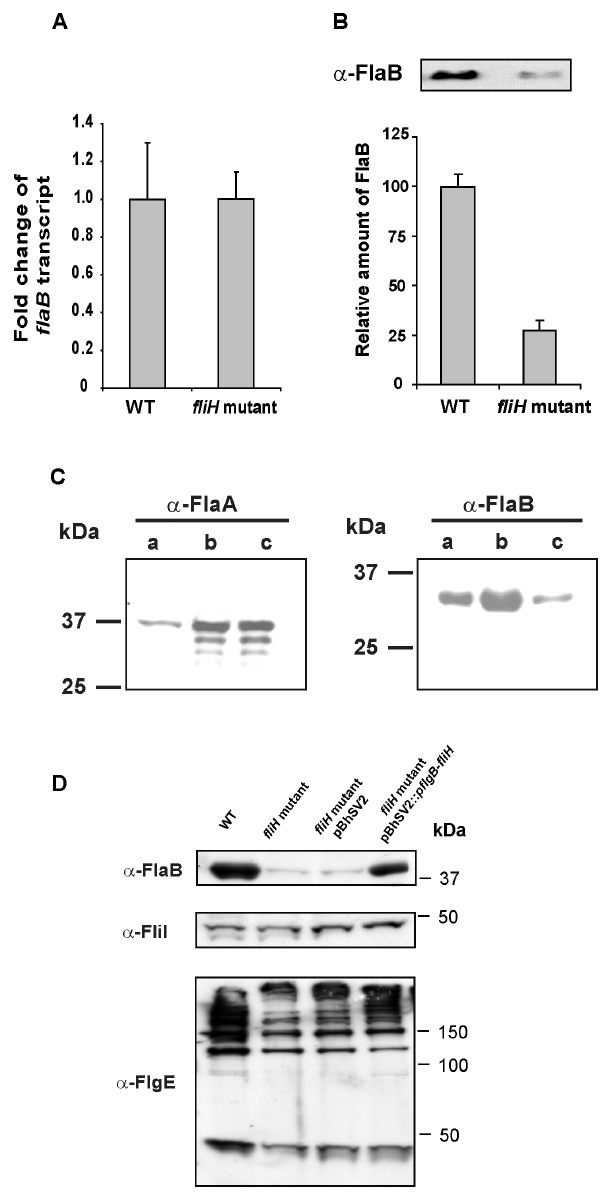
Figure 6. Comparison of flaB gene transcription and synthesis of flagellar proteins in B. hermsii wild-type (WT) and fliH mutant. (A) Fold change of flaB transcript normalized to glpQ transcript was obtained from 3 individual cultures of WT and fliH mutant spirochetes. (B) Relative amounts of FlaB protein were normalized to GlpQ protein measured by semi-quantitative immuno- blot using 3 lysates of the WT and mutant B. hermsii . (C) Immunoblot analysis of purified periplasmic flagella from wild-type B. hermsii (lanes a), lysates of wild-type B. hermsii (lanes b) and the fliH mutant (lanes c) probed with anti-FlaA antibody (left panel) and anti- FlaB (H9724) antibody (right panel). Molecular mass standards are shown on the left in kDa. (D) Comparative anti-FlgE and anti-FliI immunoblot analyses of WT, fliH mutant, fliH mutant pBhSV2 and fliH mutant pBhSV2:: pflgB-fliH spirochetes.